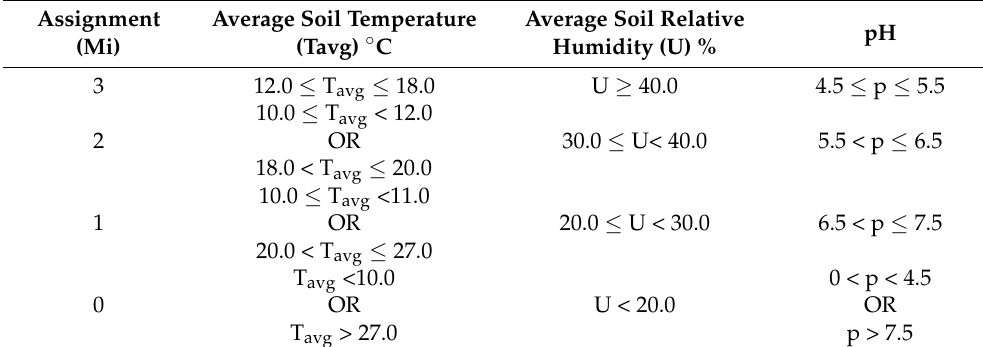
Table 2. Grading assignment method for soil indicators in the tea soil environmental quality evalua- tion